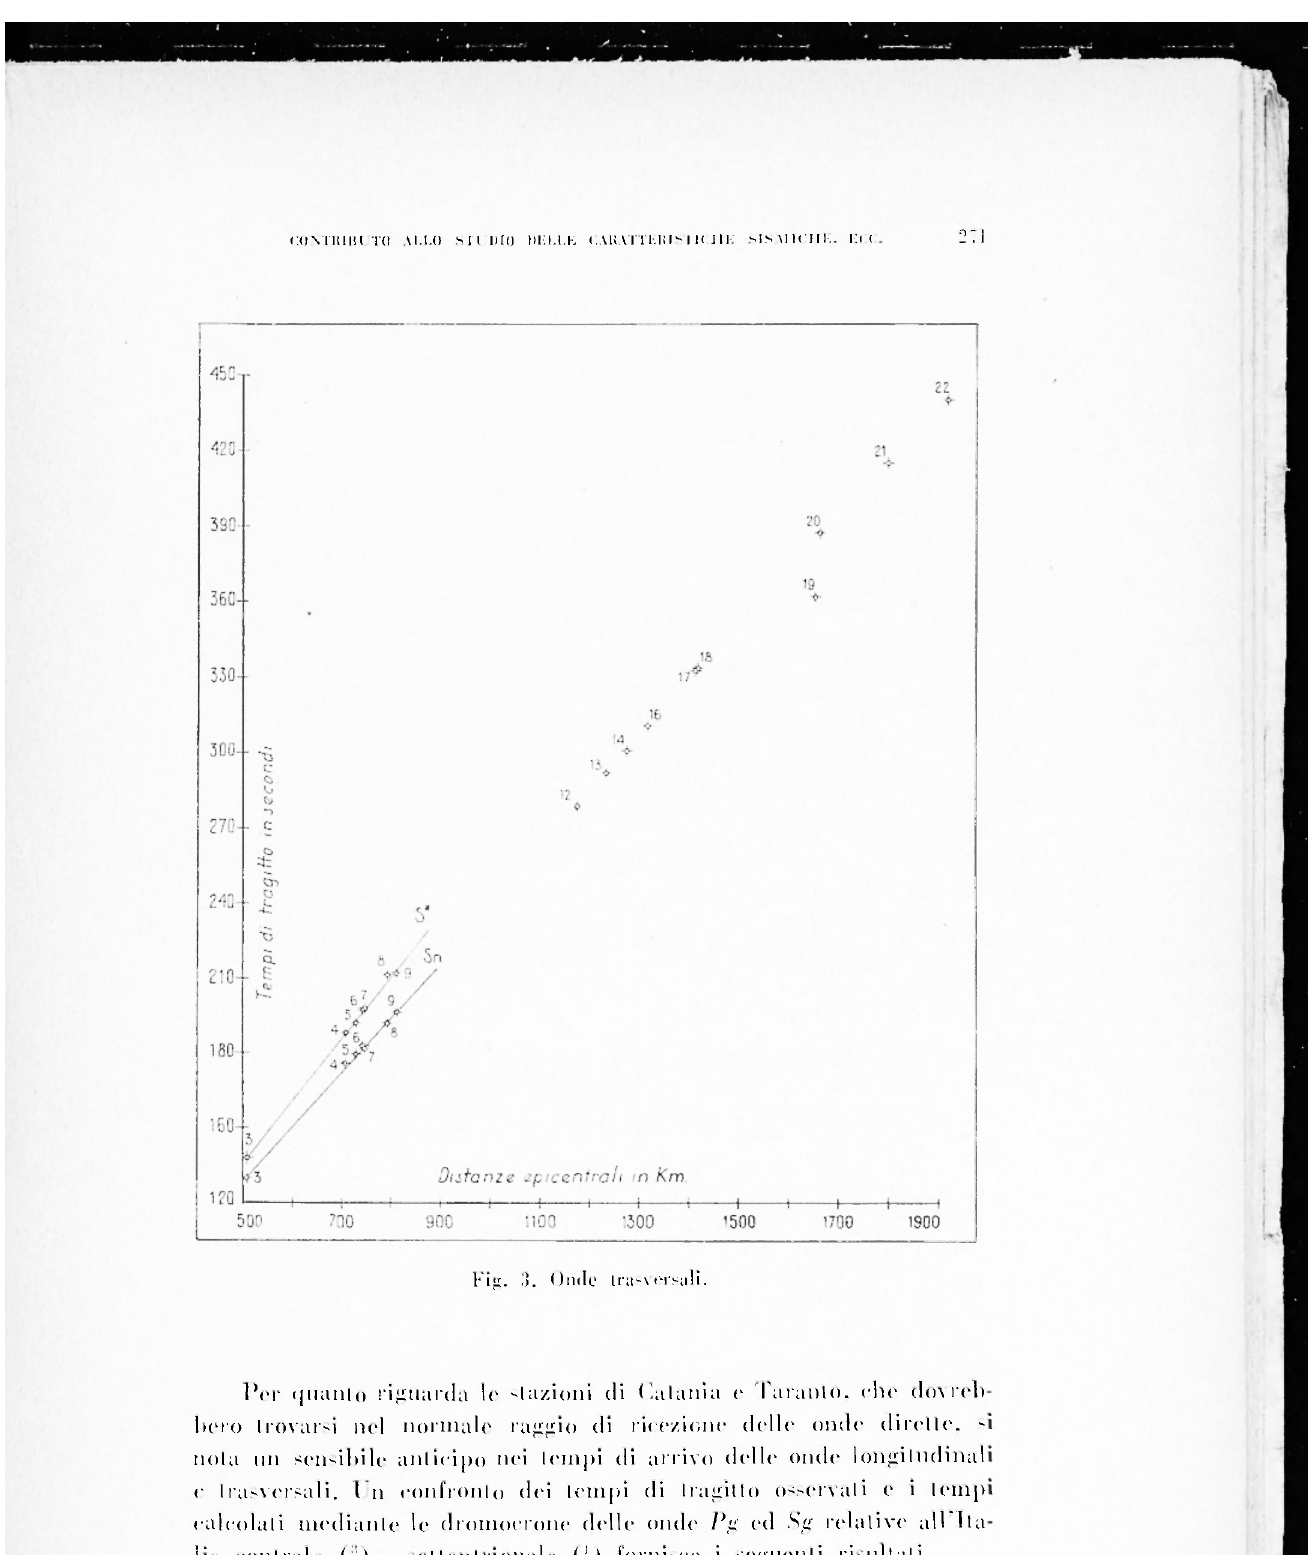
fornisce i seguenti